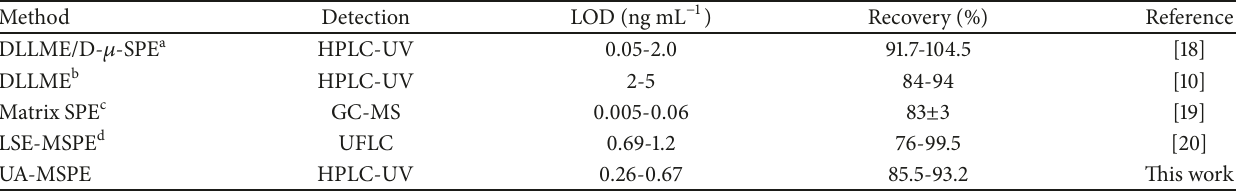
Table 3: Comparison of the proposed method and some other methods for pyrethroids determination. Method